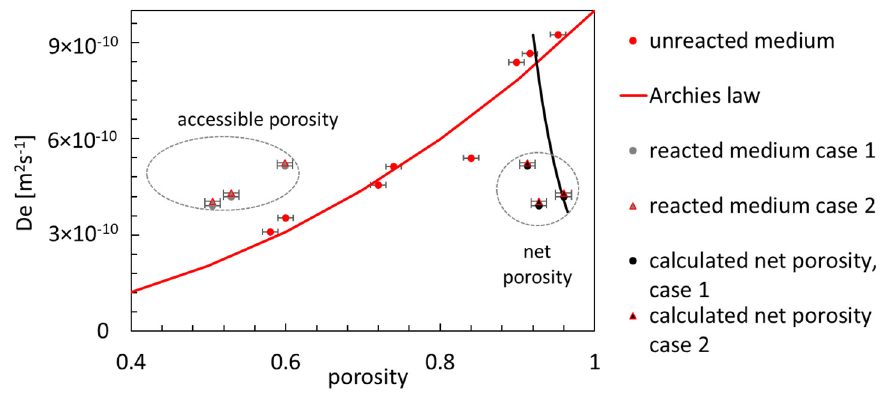
Figure 7. Graph relating porosities of sampled areas with effective